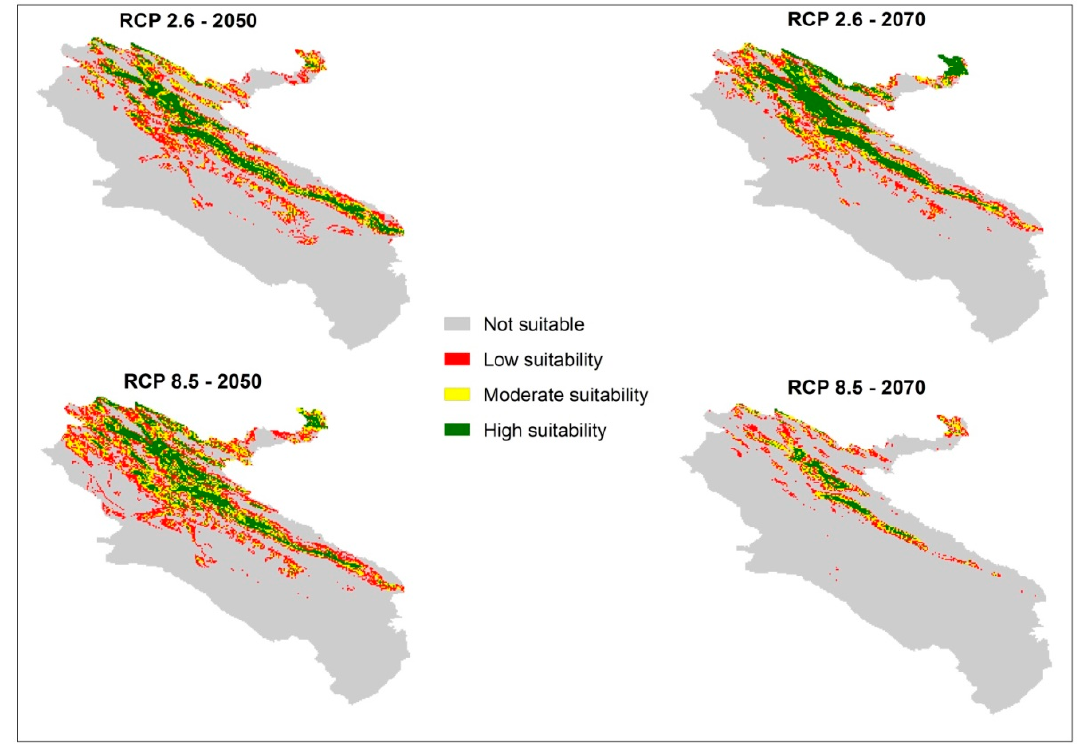
Figure 7. Habitat suitability maps for Persian oak ( Quercus brantii ) in the west of Iran based on the BART model under future climatic conditions.